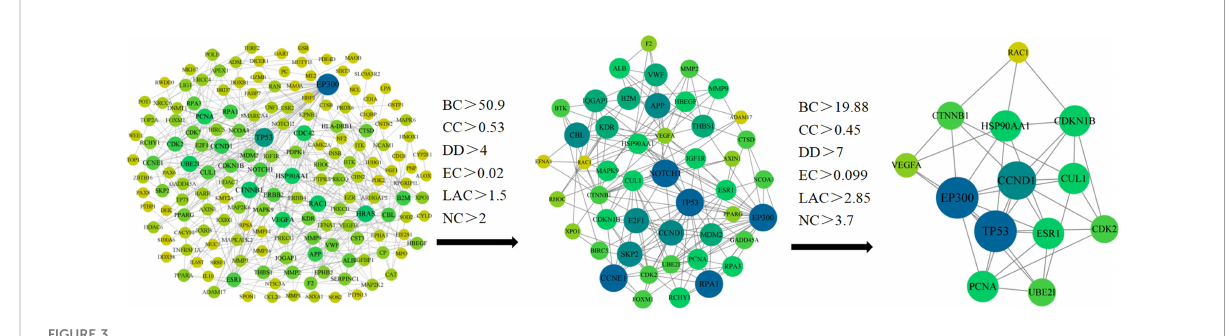
FIGURE 3 RXLD-related GBM targets ’ PPI network.